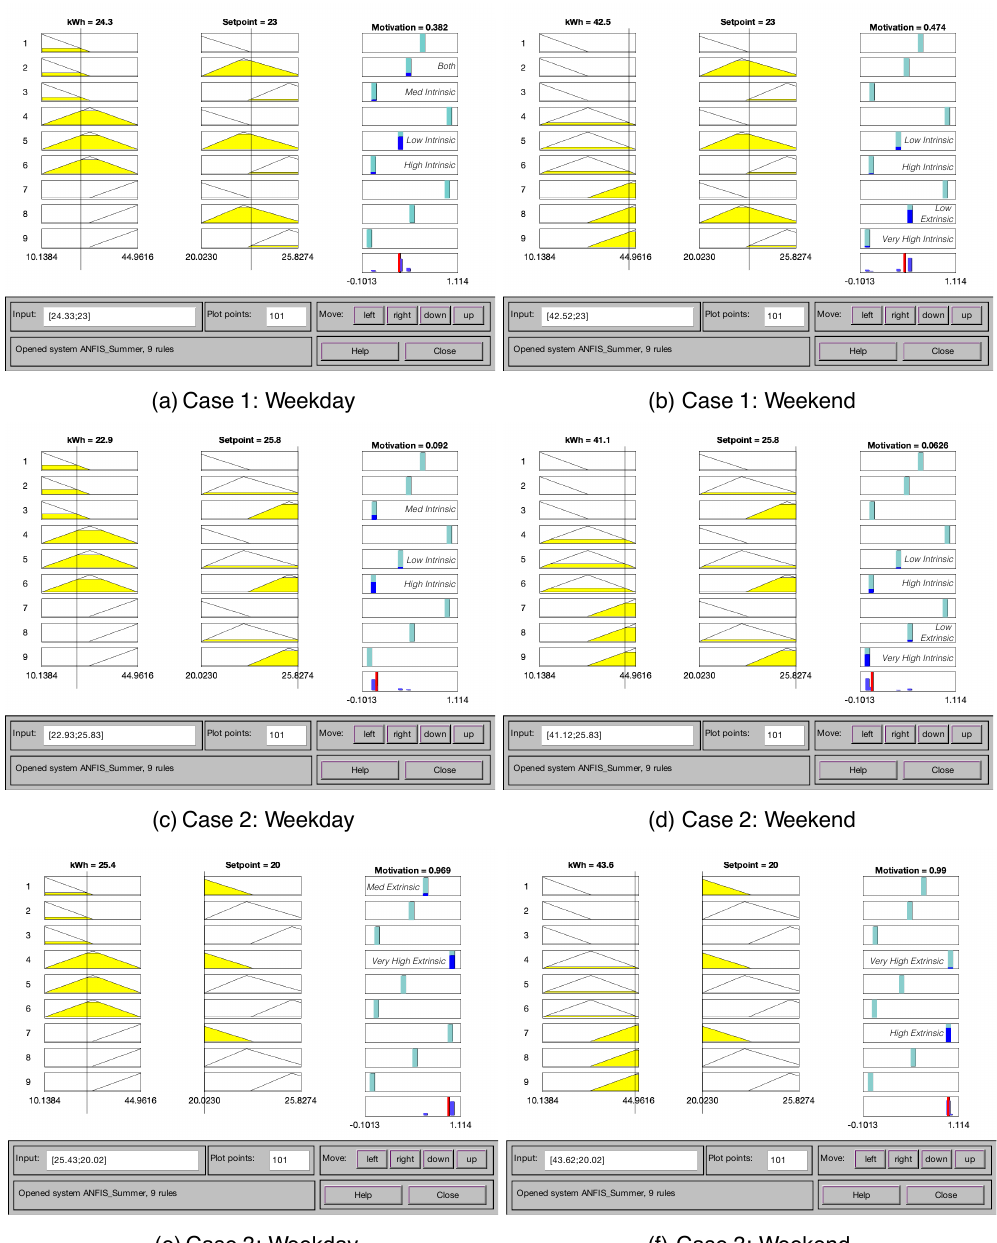
Figure 13. Neuro-fuzzy rules for summer